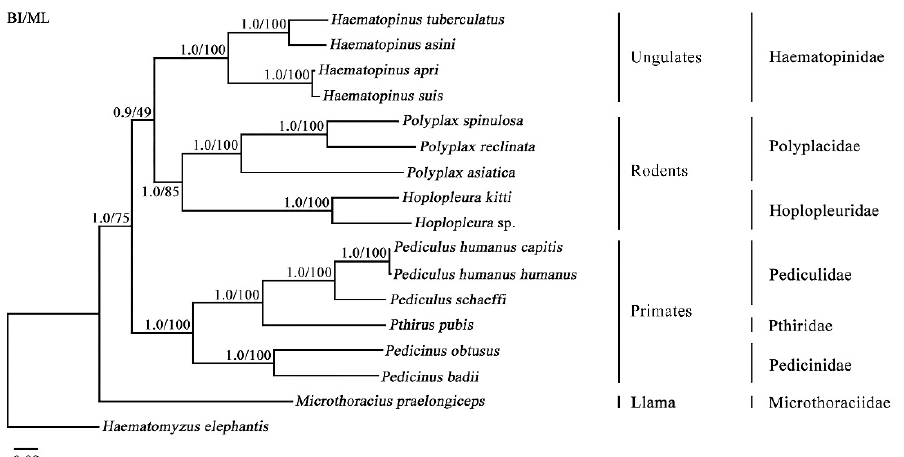
Figure 5. Phylogenetic relationships among 17 species of the parvorder Anopluran lice inferred by Bayesian inference method (BI) and maximum likelihood (ML) of deduced amino acid sequences of eight mitochondrial proteins using MrBayes and IQ-Tree. The elephant louse, Haematomyzus elephantis , was used as the outgroup. Posterior probability values (Bpp) and bootstrap values (Bv) are indicated at nodes.